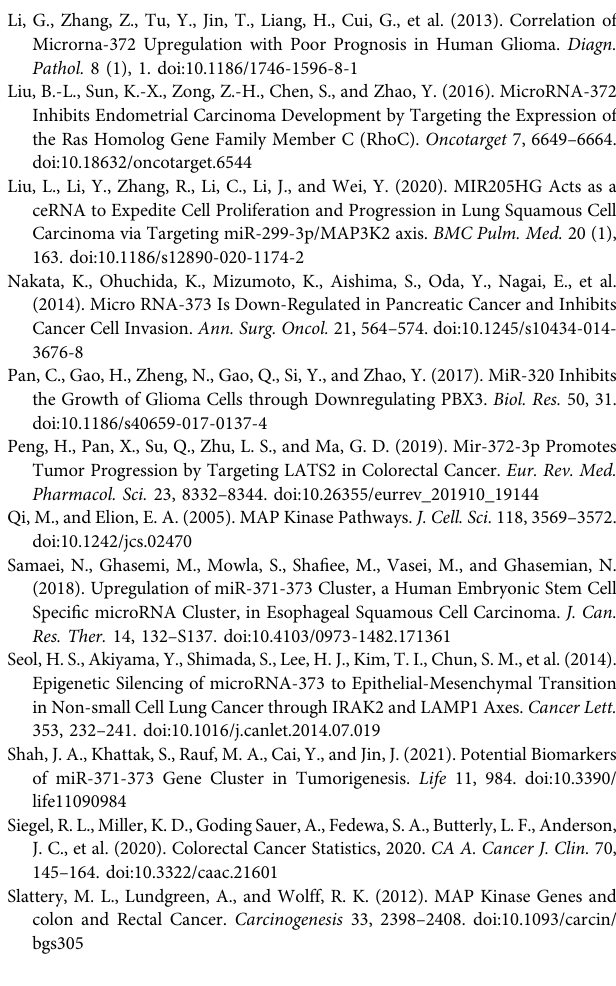
Supplementary Figure S1 | (A) The diagram of miR-372-3p expression plasmid construction. (B) Con fi rmation of miR-372-3p expression in SW480 cells. Cells were transfectedwith0,1,or3 µgofmR-miR-372-3pplasmidsinthepresenceorabsence of 300 pmol of miR-372-3p inhibitors. Then, 48 h later, miR-372-3p levels were measured by qPCR. Data are presented using mean ± standard deviation values. ** p < 0.01,*** p < 0.001,MannWhitneytestwasperformedbetweenmiR-372-3pand miR-372-3p+inhibitorcells. (C) MTTassay.SW480cellsweretransientlytransfected